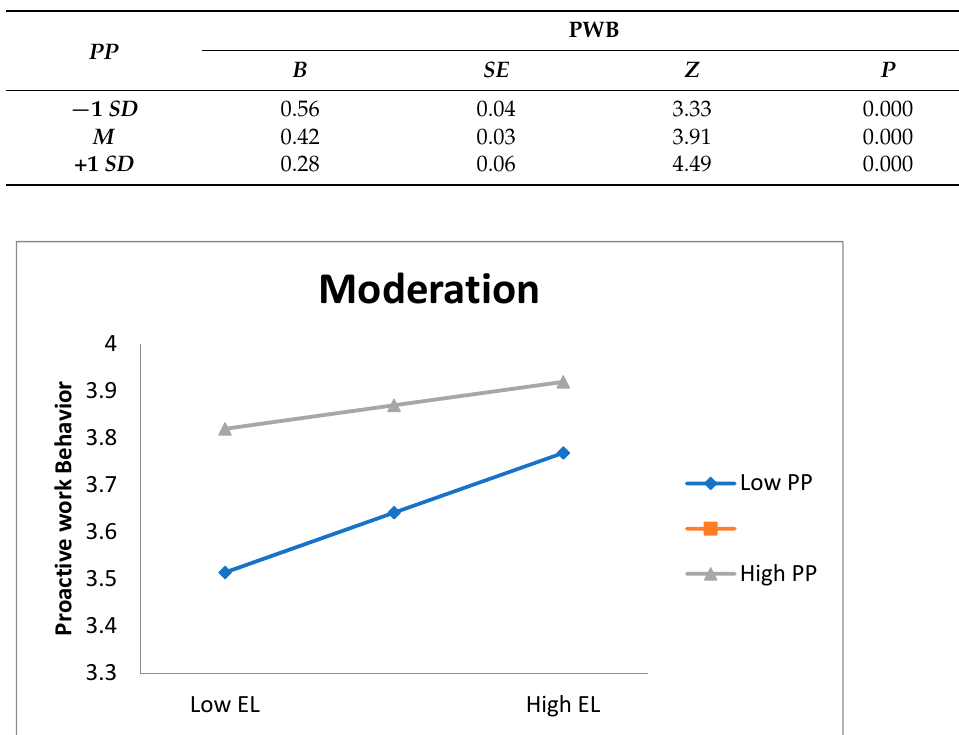
Figure 2. Moderation relationship plot. EL = entrepreneurial leadership, PP = proactive personal- ity.